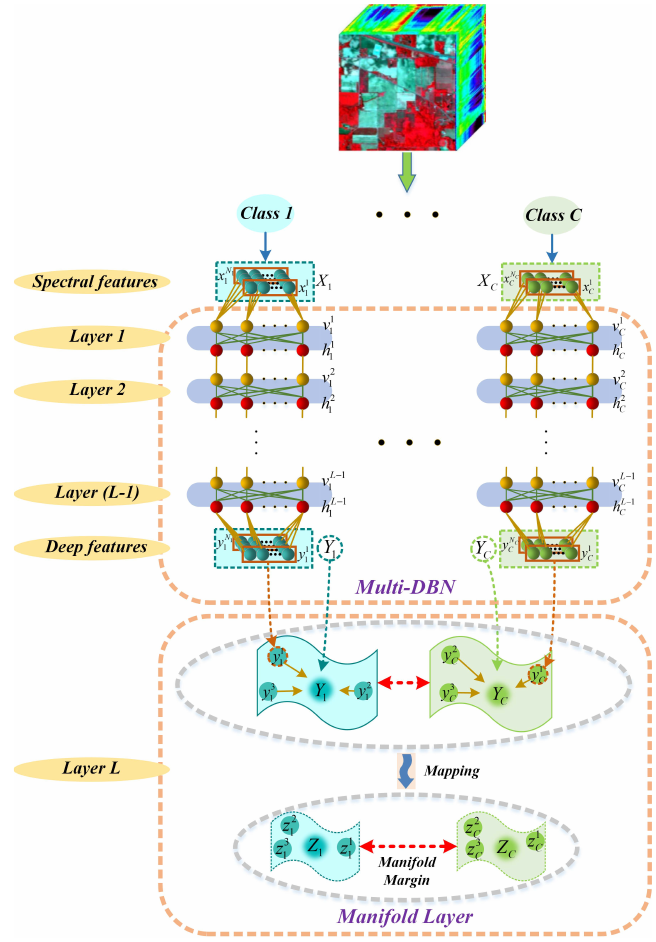
Figure 3. Process of the proposed multi-DBN-manifold